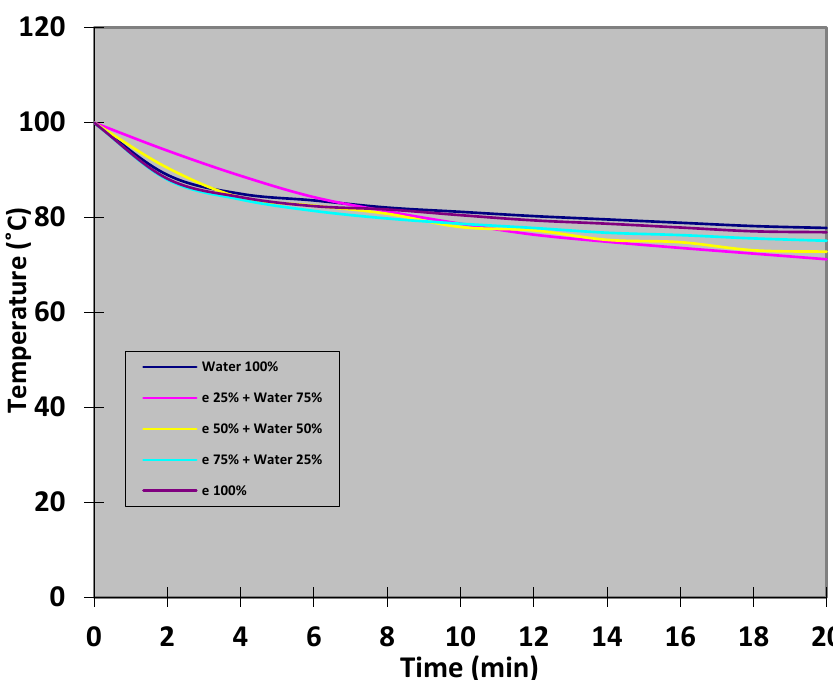
Figure 3. Surface temperature of the heater block for different liquid coolants at the 0.3 GPM flow rate.